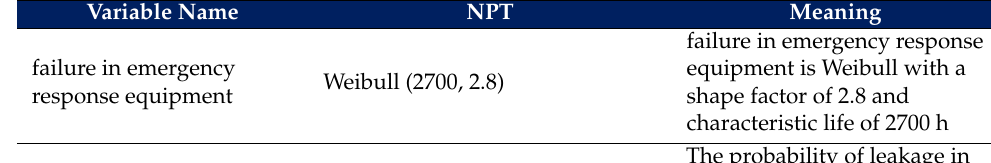
Table 6. NPT of the variables describing safety factors and social